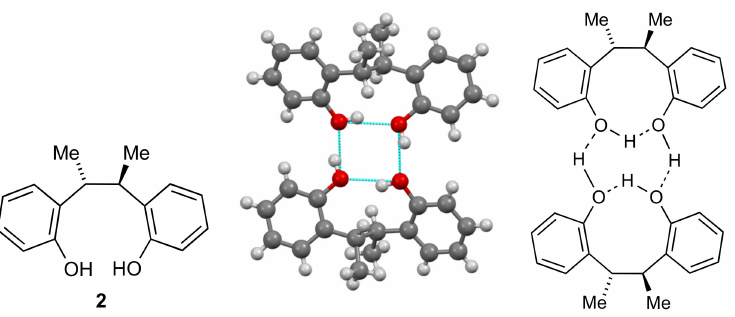
Figure 5. Molecular and crystal structure of 2